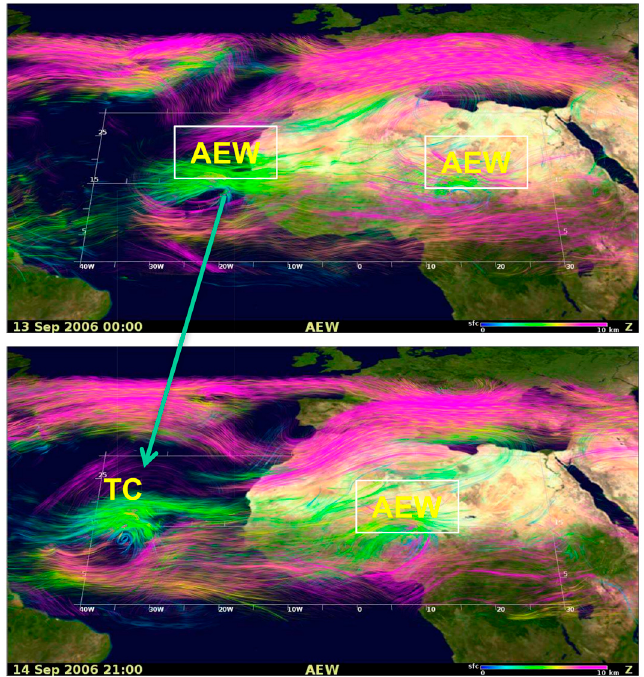
Figure 7. A visualization of formation of Hurricane Helene (2006) and its association with the intensification of an African Easterly Wave (AEW) in a 30-day run initialized at 0000 UTC 22 August 2006. Upper-level winds are shown in pink, middle-level winds in green, and low-level winds in blue. ( top ) Initial formation of Helene as the AEW moves into the ocean, validated at 0000 UTC 13 September 2006 (day 22); ( bottom ) initial intensification associated with intensified low-level inflow with counter clockwise circulation, validated at 2100 UTC 14 September 2006. An animation can be found at: http://tiny.cc/j9ul9 (courtesy of [41]).